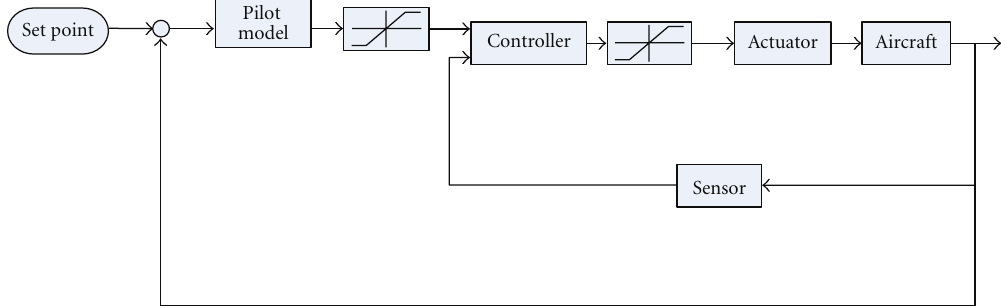
Figure 1: Rate limiting in flight control systems.